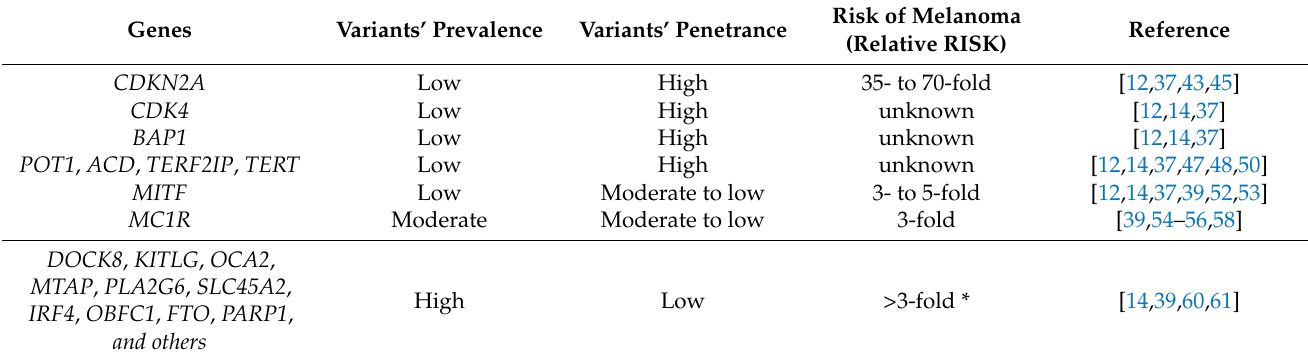
Table 1. The role of the main melanoma-susceptibility genes in melanoma